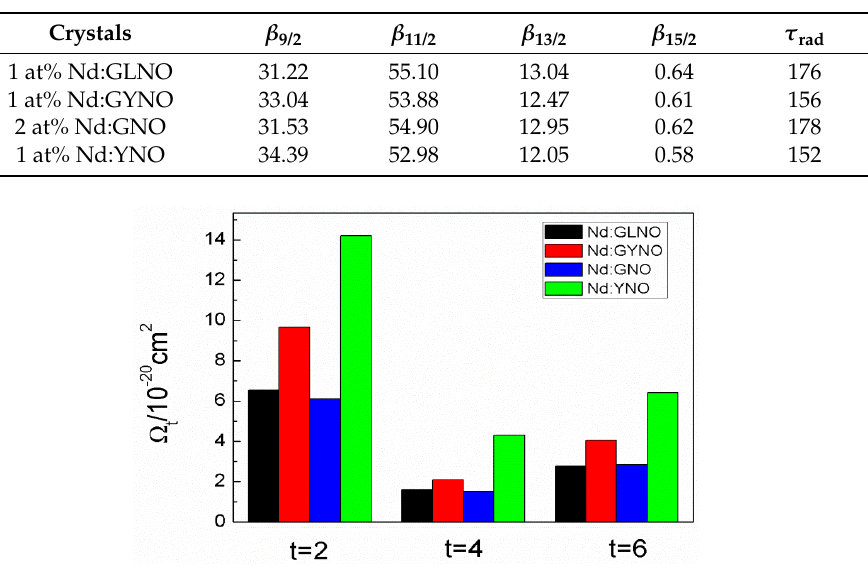
Table 7. Comparisons of τ rad and β (J,J (cid:48) ) between Nd:GNO, Nd:YNO, Nd:GYNO, and Nd:GLNO crystals.